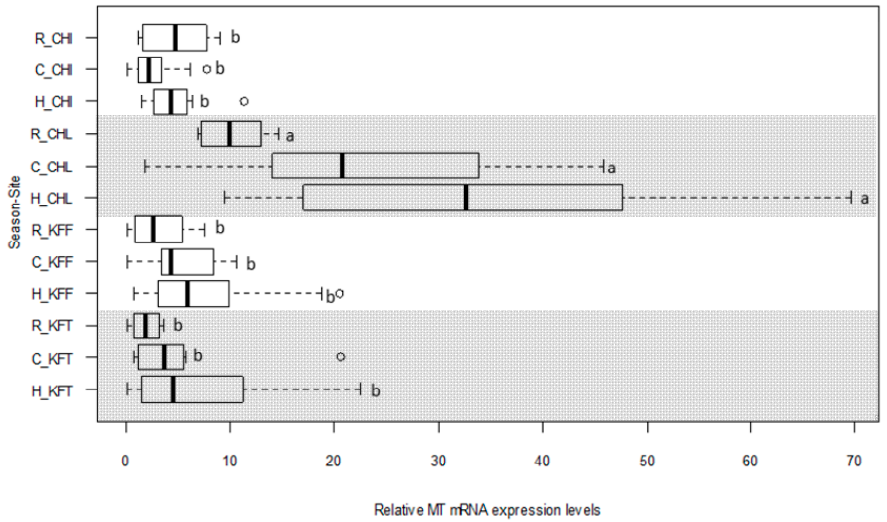
Figure 7. CgMT mRNA expression levels in liver tissue of C. gariepinus collected from 4 sample sites (CHI = Chimfunshi, CHL = Chililabombwe, KFF = Kafue Flats, KFT = Kafue Town) during three distinct seasons (R = warm-rainy season, C = dry-cold season, H = dry-hot season). CgMT levels were determined by qPCR (7500 Fast Real-Time PCR System, Applied BioSystems) from each season/site condition, each of which consisted of 10-18 individual biological replicates (see Table S3). CgMT quantification was performed using three technical replicates per sample and was normalised to β -actin . One-way ANOVA followed by a post-hoc Tukey’s (HSD) test was applied to assess for spatial and seasonal differences in MT expression levels. Different letters (“a” and “b”) indicate a statistically significant difference ( p < 0.05) between sites in each season. The ○ symbols in this box-and-whiskers plot denote outliers.